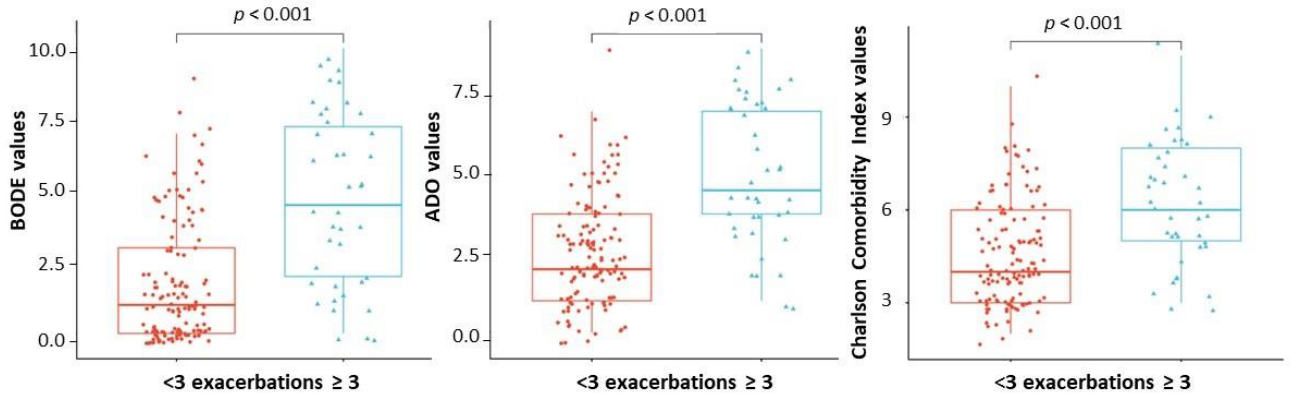
Figure 8. Jitter plot values of the BODE, ADO and Charlson Comorbidity Index in patients with an exacerbation frequency of up to three and more than three per year.